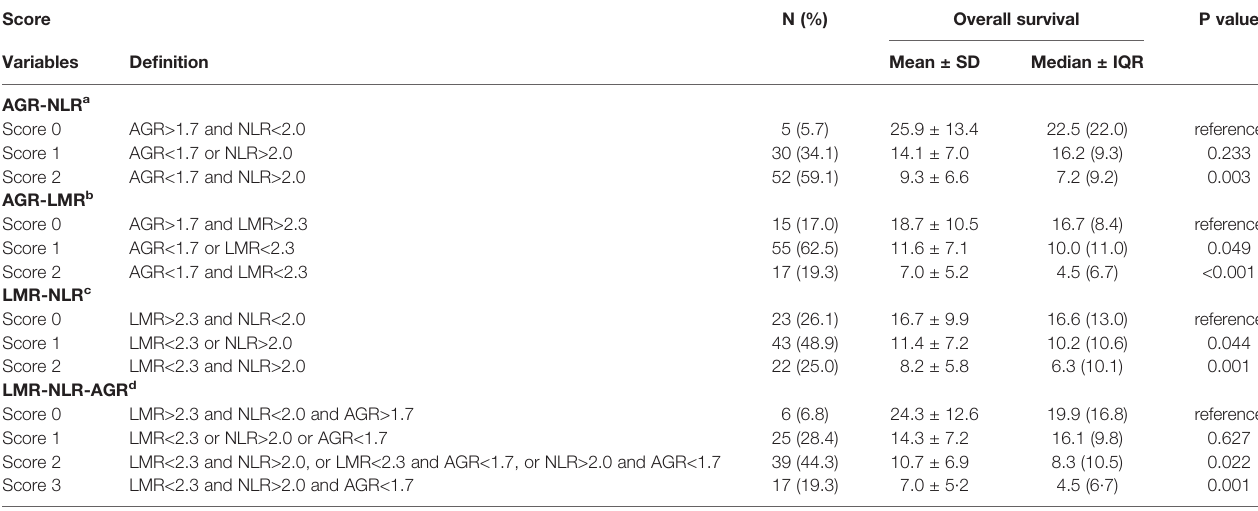
TABLE 3 | Overall survival of GBM cohorts based on different score